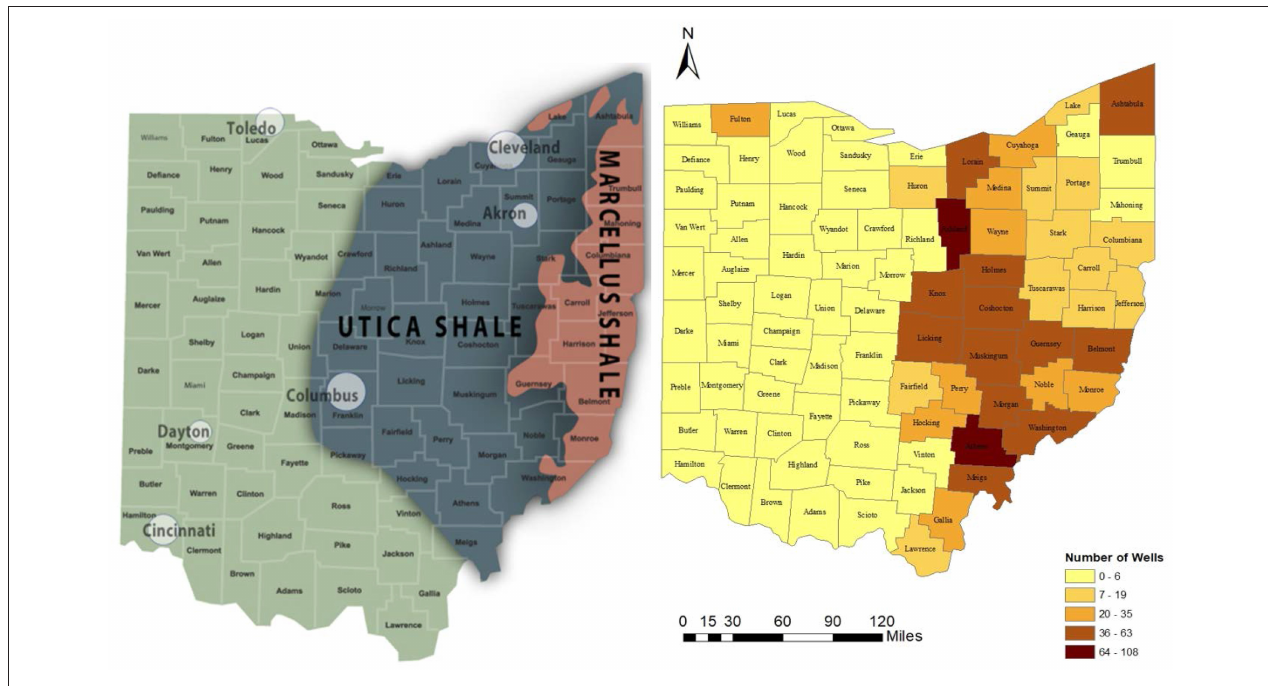
FIGURE 1 | Distributions of Marcellus and Utica Shales in Ohio (8, 9).